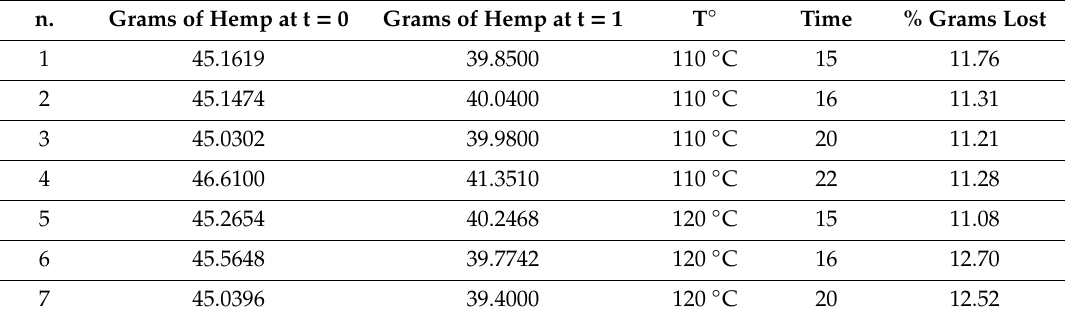
Table 1. Hemp samples subjected to drying at di ff erent times and temperatures.